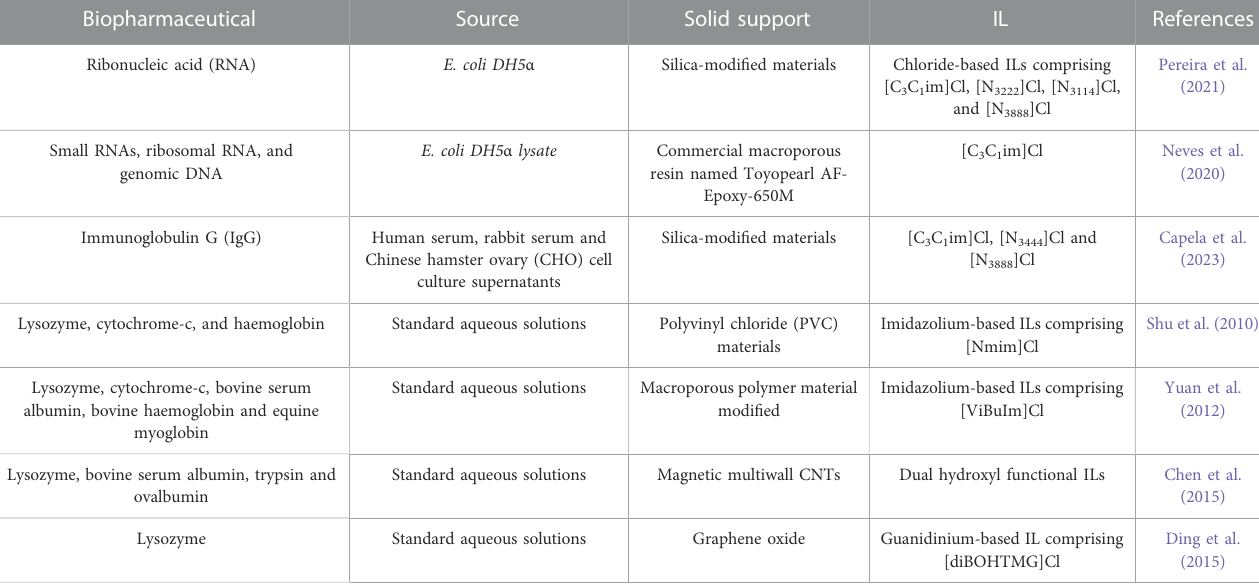
TABLE 2 Representative works regarding the recovery and puri fi cation of biopharmaceuticals using solid-liquid approaches based on SILs.